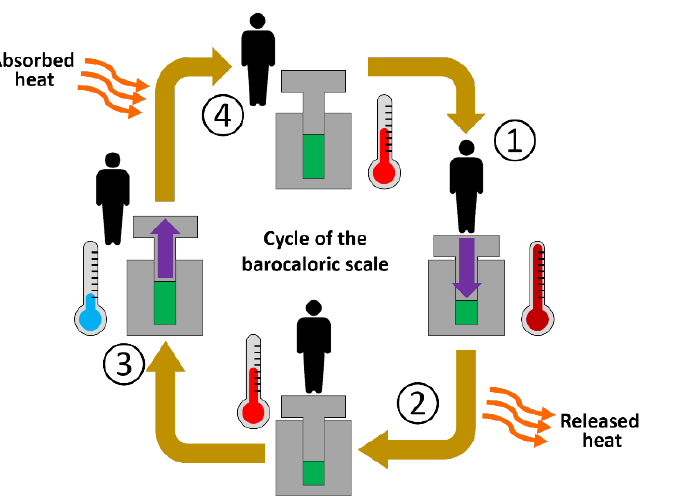
Figure 2. Simple schematics of a barocaloric heating/cooling cycle generated in our barocaloric scale.